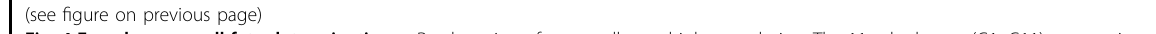
Fig. 4 Female germ cell fate determination. a Re-clustering of germ cells at a higher resolution. The 11 sub-clusters (G1 – G11) were assigned and colored as indicated on the fi gure key. b Cell lineage reconstruction using monocle2. Sub-cluster G1 represents the start of pseudotime, with sub- cluster G11 at the end. c Dynamic expression of stage-speci fi c genes along pseudotime. d Overlap of highly variable genes among G7 – G10 sub- clusters. e GO analysis of differentially expressed genes in clusters G7 – G10. f Heatmap representing the survival, apoptosis, and meiotic genes